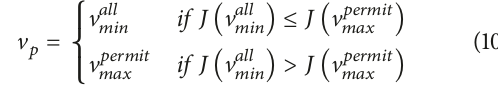
Figure 5: The fuel consumption at different velocity.